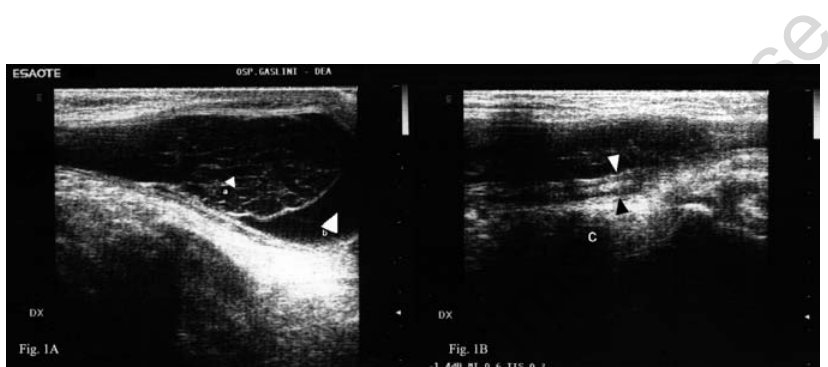
Figure 1. US longitudinal section of the right inguinal canal. A. The lumen of the canal is occupied by omental sheets (a) and peritoneal fluid (b). B. The appendix (arrowheads) is close to omental structure (c) with its typical layered intestinal appearance and its blind end.